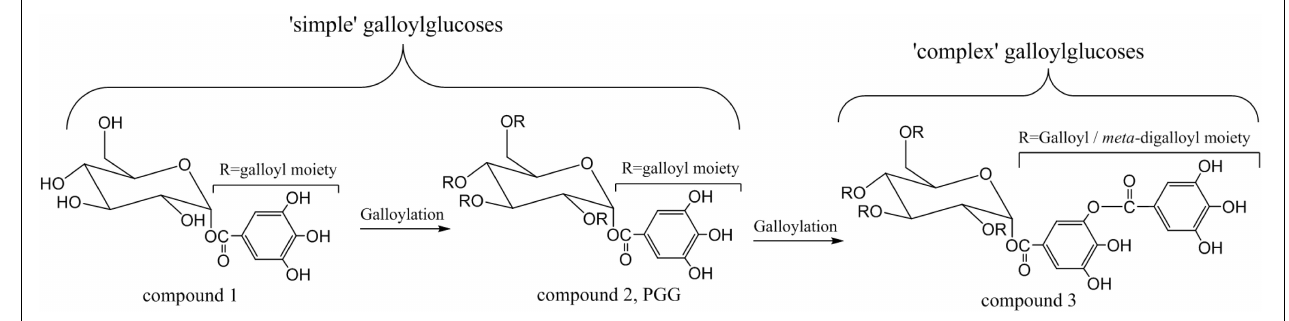
FIGURE 1 | The structural illustration of